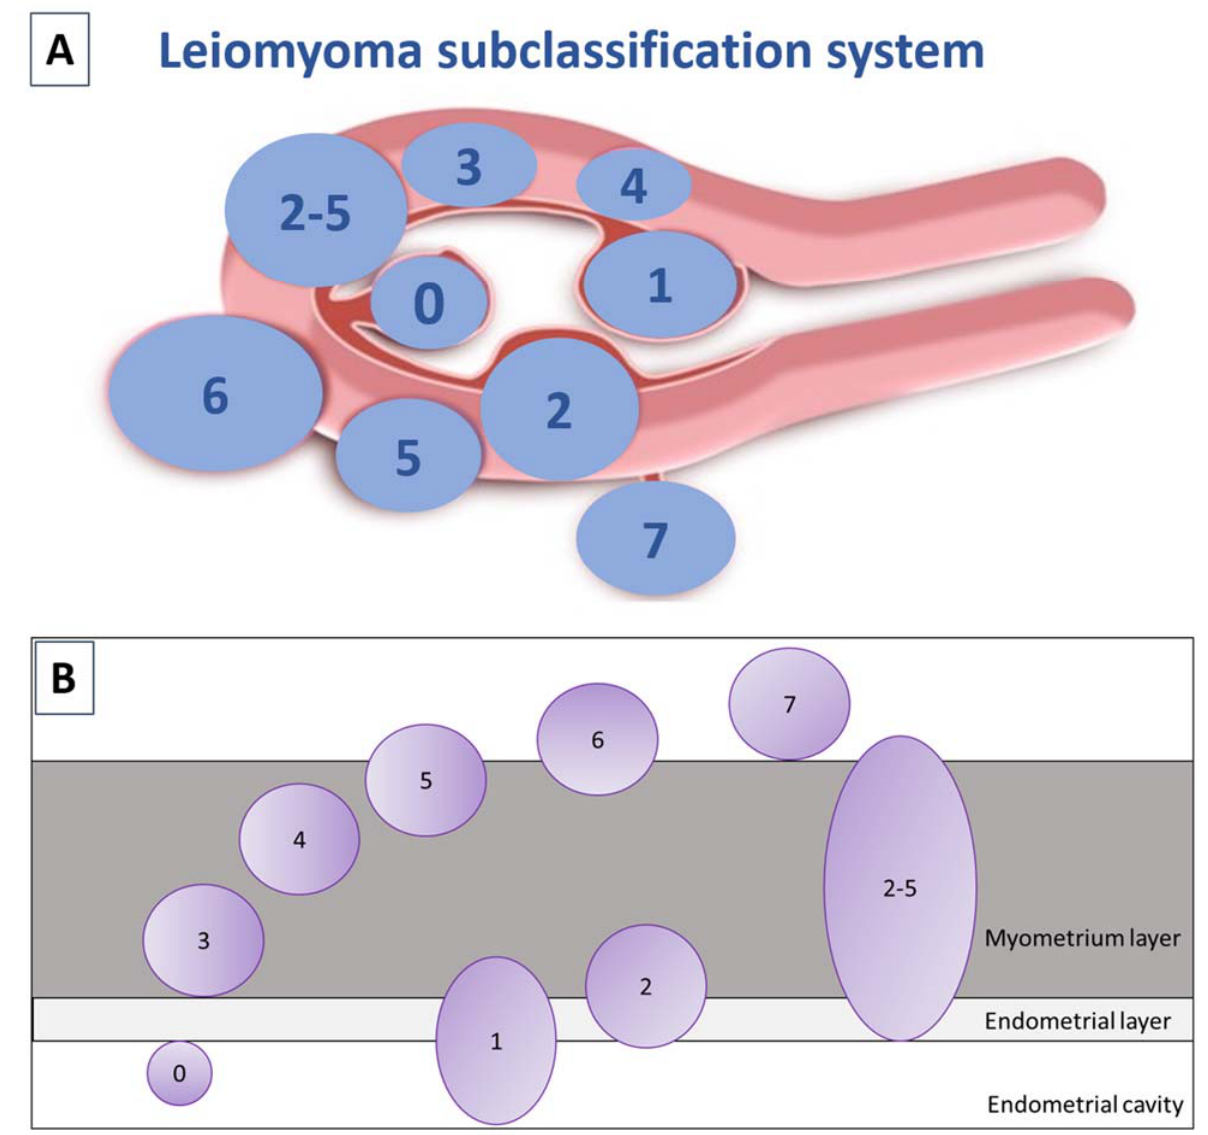
Figure 1. ( A ) FIGO subclassification of leiomyomas according to Munro et al., 2011. Fibroid types range from 0 to 8: 0 = pedunculated (intracavitary); 1 = submucosal (<50% intramural); 2 = submucosal ( ≥ 50% intramural); 3 = contact with endometrium (100% intramural); 4 = intramural; 5 = subserosal ( ≥ 50% intramural); 6 = subserosal (<50% intramural); 7 = subserosal (pedunculated); and 8 = other (cervical, parasitic). Where two numbers are given (2–5), the first number pertains to the relationship with the endometrium, and the second with the serosa, so 2–5 is both submucosal and subserosal, with less than half of its diameter in the endometrial and peritoneal cavities respectively. Diagram showing the classification system adapted from Munro et al. [9]. ( B ) Relationship between fibroids and the myometrium adapted by Donnez and Dolmans, 2020 [10].